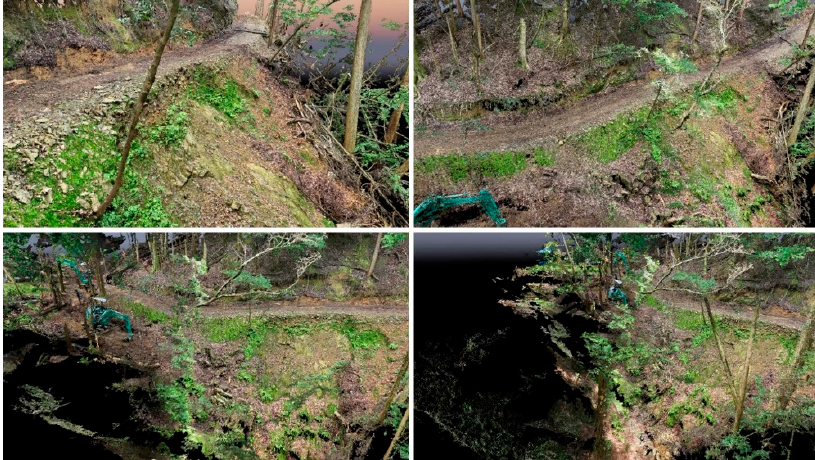
Figure 1. A 3D model generated by SfM analysis before the repair work started.